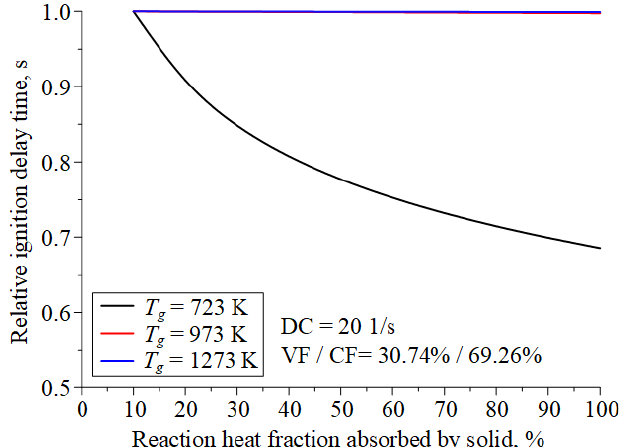
Figure 7. Relative ignition-delay times of CLF No. 4 (FC 90% + plastic 10%) vs. reaction heat fraction absorbed by the solid of the combusting particle at different temperatures of the radiant heating source.